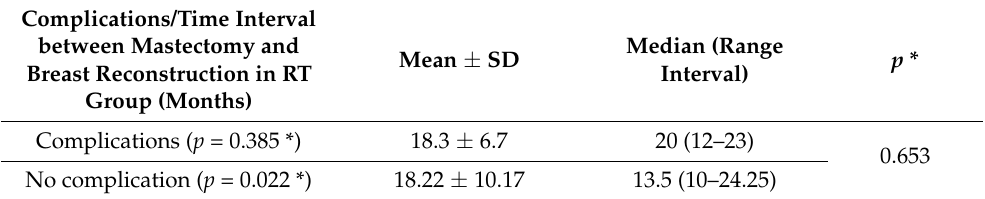
Table 2. Time interval between mastectomy and breast reconstruction in patients with radiotherapy. Complications/Time Interval